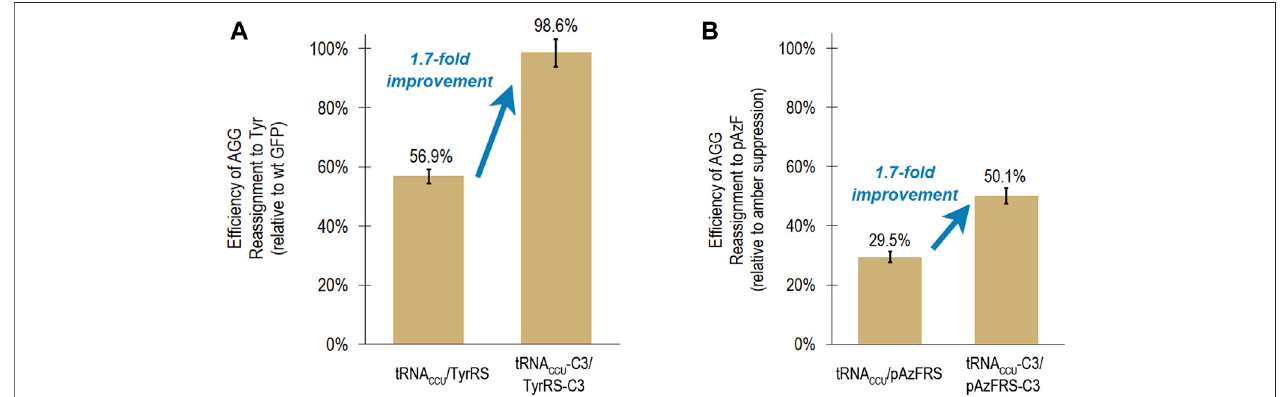
FIGURE 3 | Transferability of mutations that led to increased reassignment of the AGG codon to tyrosine to an aaRS capable of incorporating a ncAA ( para - azidophenylalanine). In both cases, the same suite of mutations to the tRNA anticodon loop and aaRS anticodon binding domain resulted in a 1.7-fold improvement in reassignment ef fi ciency. (A) Ef fi ciency of AGG sense codon reassignment to tyrosine by two orthogonal pairs: M. jannaschii tRNA CCU /TyrRS and tRNA CCU -C3/TyrRS- C3. Reported ef fi ciencies are the mean and standard deviation for 24 biological replicates of each system evaluated in several independent iterations of the fl uorescence-based screen. Reassignment ef fi ciencies are corroborated by fl uorescence analysis of the GFP protein mixtures isolated from these cells. (B) Ef fi ciency of AGGsensecodonreassignmenttoancAA,pAzF,bytwoorthogonalpairs: M.jannaschii tRNA CCU /pAzFRSandtRNA CCU -C3/pAzFRS-C3.Reportedef fi cienciesarethe meanandstandarddeviationofatleast4biologicalreplicatesofeachsystemquanti fi edusingthe fl uorescenceperproteinofGFPmixturesisolatedfromthesecells.The “ 100% pAzF incorporation ” control in each experiment is based on the fl uorescence per protein analysis of full length GFP proteins produced after suppression of an amber stop codon in the fl uorophore position